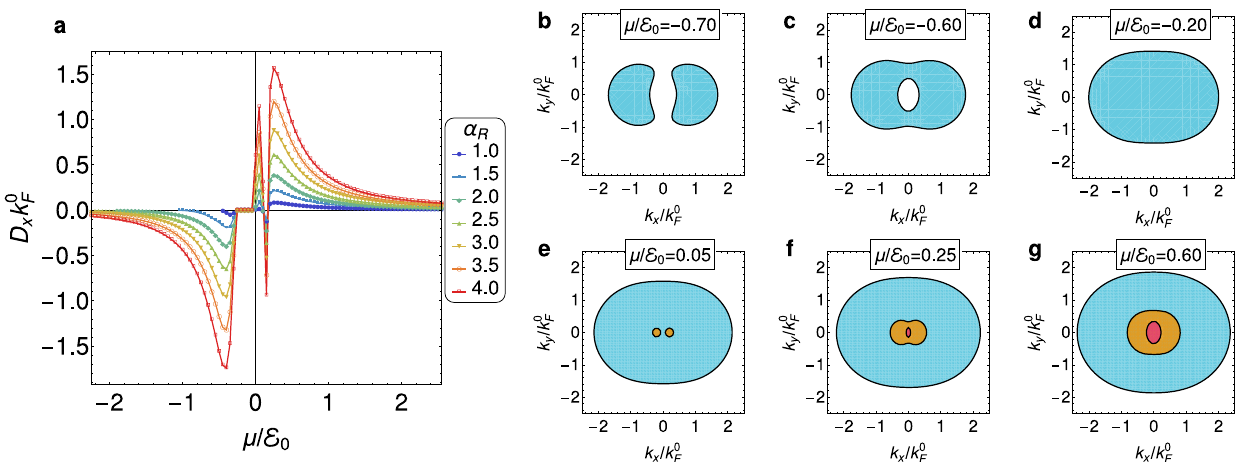
Fig. 4 Berry curvature dipole and topology of the Fermi lines. a Behavior of the Berry curvature dipole obtained by changing the chemical potential μ measured in units of E 0 . The different curves correspond to the different values of α R measured in units of E 0 = k 0 parameters have been instead fi xed as Δ ¼ (cid:2) 0 : 2 E 0 , Δ m ¼ (cid:2) 0 : 01 E 0 , α m = α R . b – f display the Fermi lines and the band-resolved occupied regions in momentum space for α R ¼ α m ¼ 1 : 5 E 0 = k 0 F